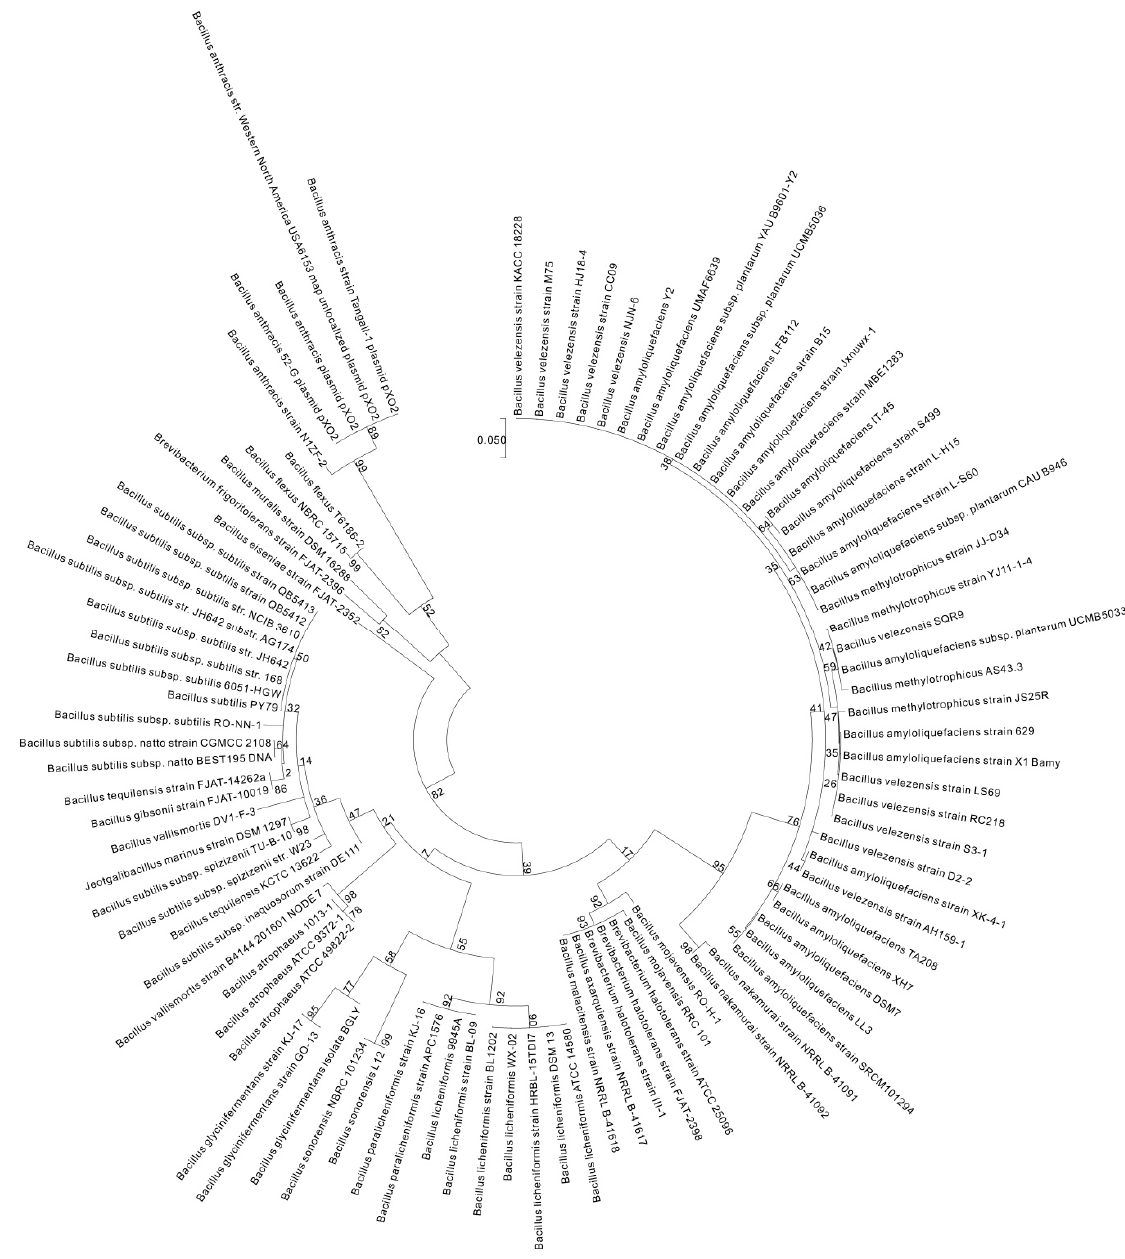
Figure 5. Molecular phylogenetic analysis of pgsA by the maximum likelihood method. The phylogenetic tree with branch lengths was measured as the number of substitutions per site. The analysis involved 192 nucleotide sequences. Partial deletion was used and all positions with less than 95% site coverage were eliminated, i.e., less than 5% of the alignment gaps, instances of missing data, and ambiguous bases were allowed at any position. Scale bar: number of substitutions per site. Evolutionary analyses were conducted in MEGA7 [38]